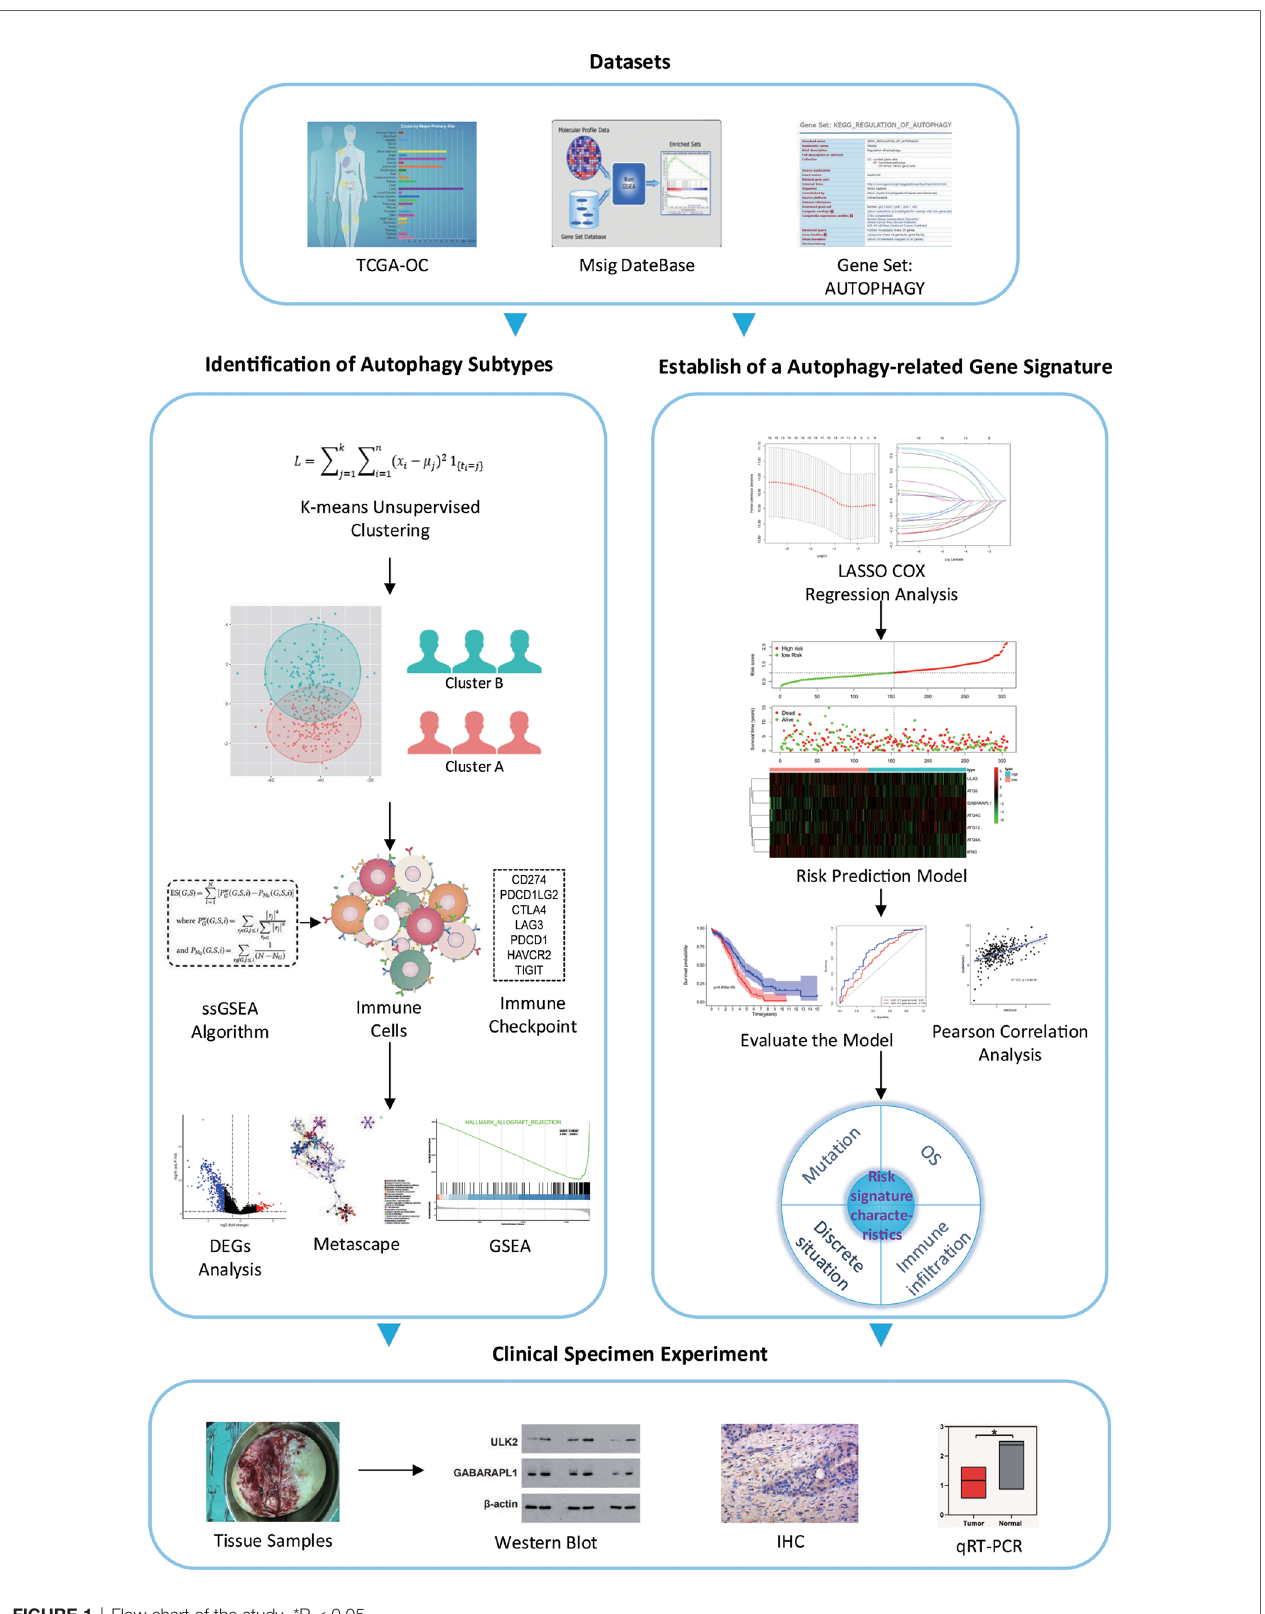
FIGURE 1 | Flow chart of the study. *P <